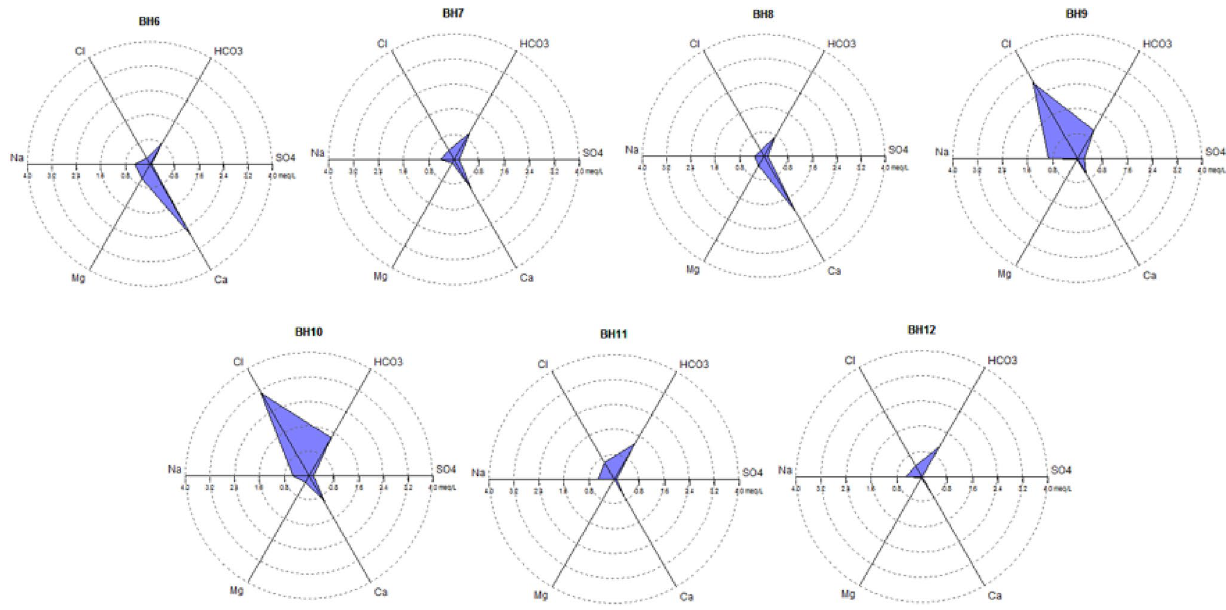
Fig. 5 Radial diagrams for samples BH6, BH7, BH8, BH9, BH10, BH11 and BH12